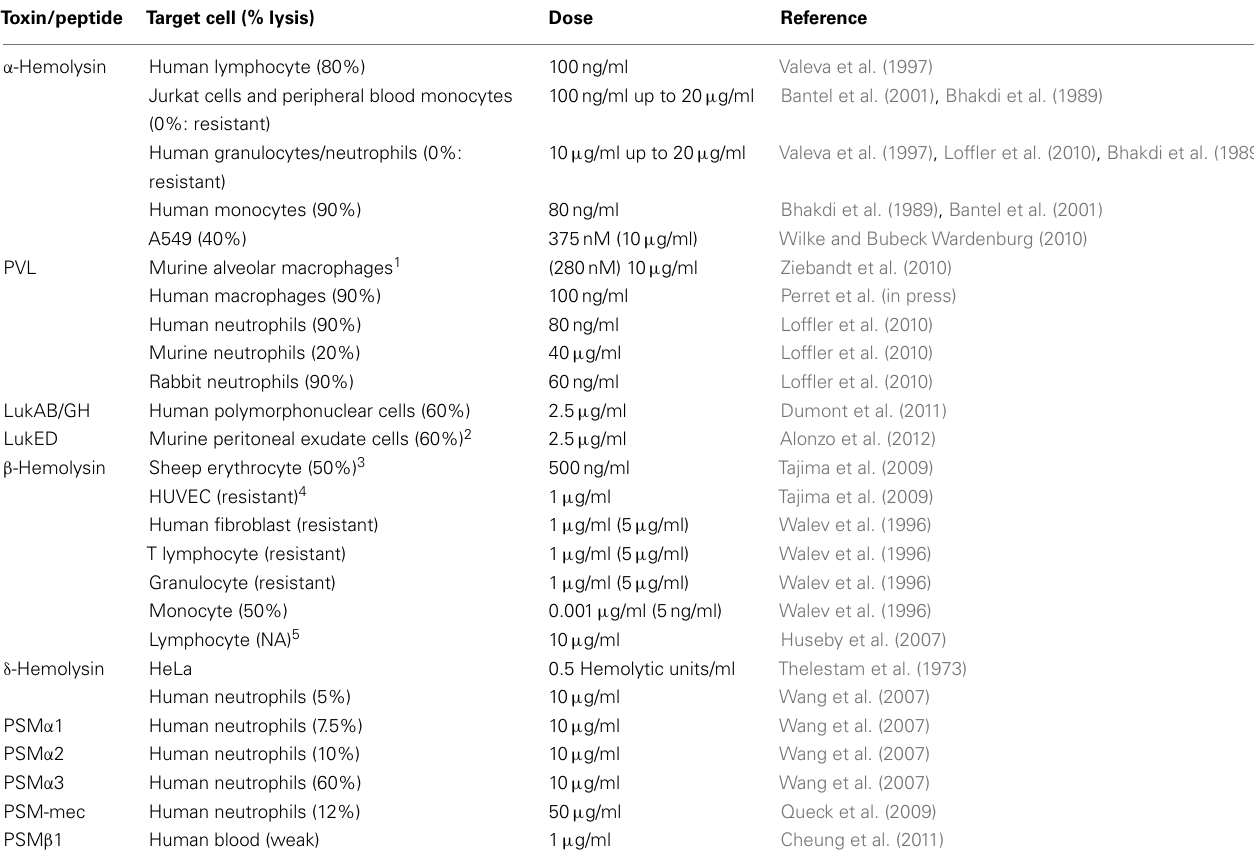
Table 1 | Species and cell type specificities of the various hemolysins, bi-component leukocidins, and PSMs. Toxin/peptide Target cell (%